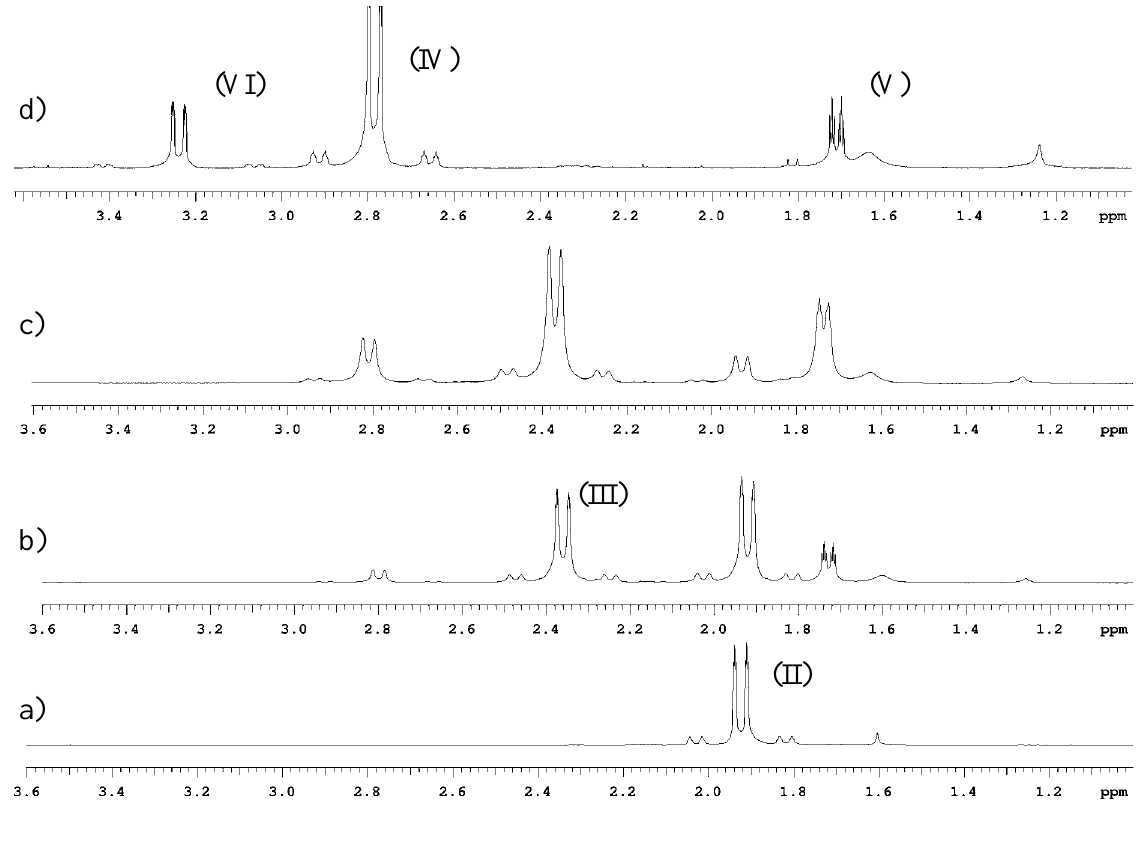
Figure 3 . Partial 1 H-NMR spectra in CDCl of the reaction of tetrallyltin with HBr(aq). 3 (a) tetrallyltin; (b) first addition; (c) second addition, d) third addition. Assignments: tetrallyltin (II); triallyltin bromide (III); diallyltin dibromide (IV), propene (V) and allyltin tribromide